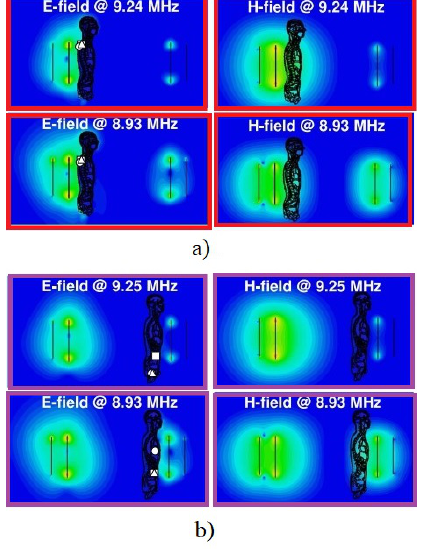
Figure 16. Electric and magnetic field distributions around the human body in proximity to the WPT system for an input power of 1 W; the body is more exposed to the generated fields by the ( a ) Tx and ( b ) Rx coil. Scale: in dB with 10 subdivisions ranging from − 80 to 0 dBV/m and − 60 to 0 dBA/m for E and H , respectively.